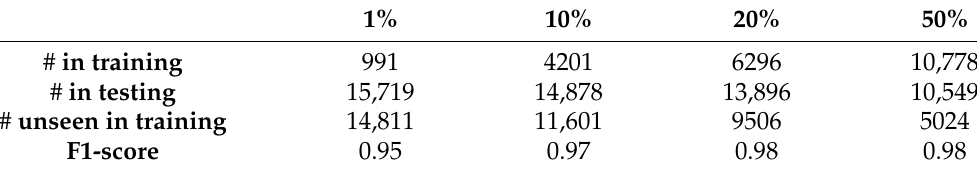
Table 6. Statistics of unseen log types on HDFS dataset (the first row is training